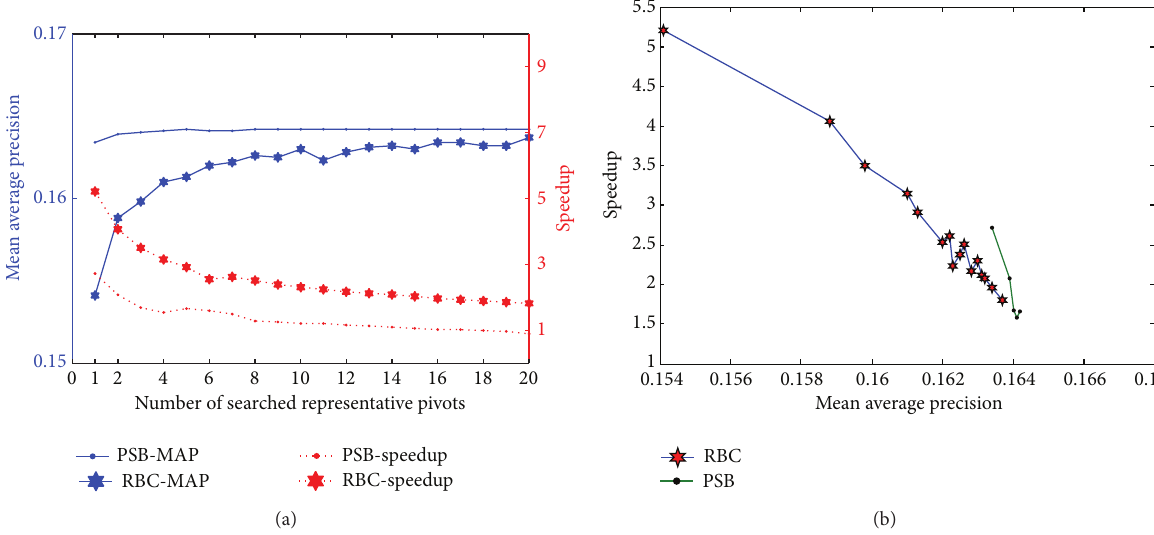
Figure 7: Performance evaluation on Corel 10K for semantic embedding and multiple representative pivots selection. (a) MAP and speedup variations with the number of representative pivots. (b) Speedup variations with MAP.